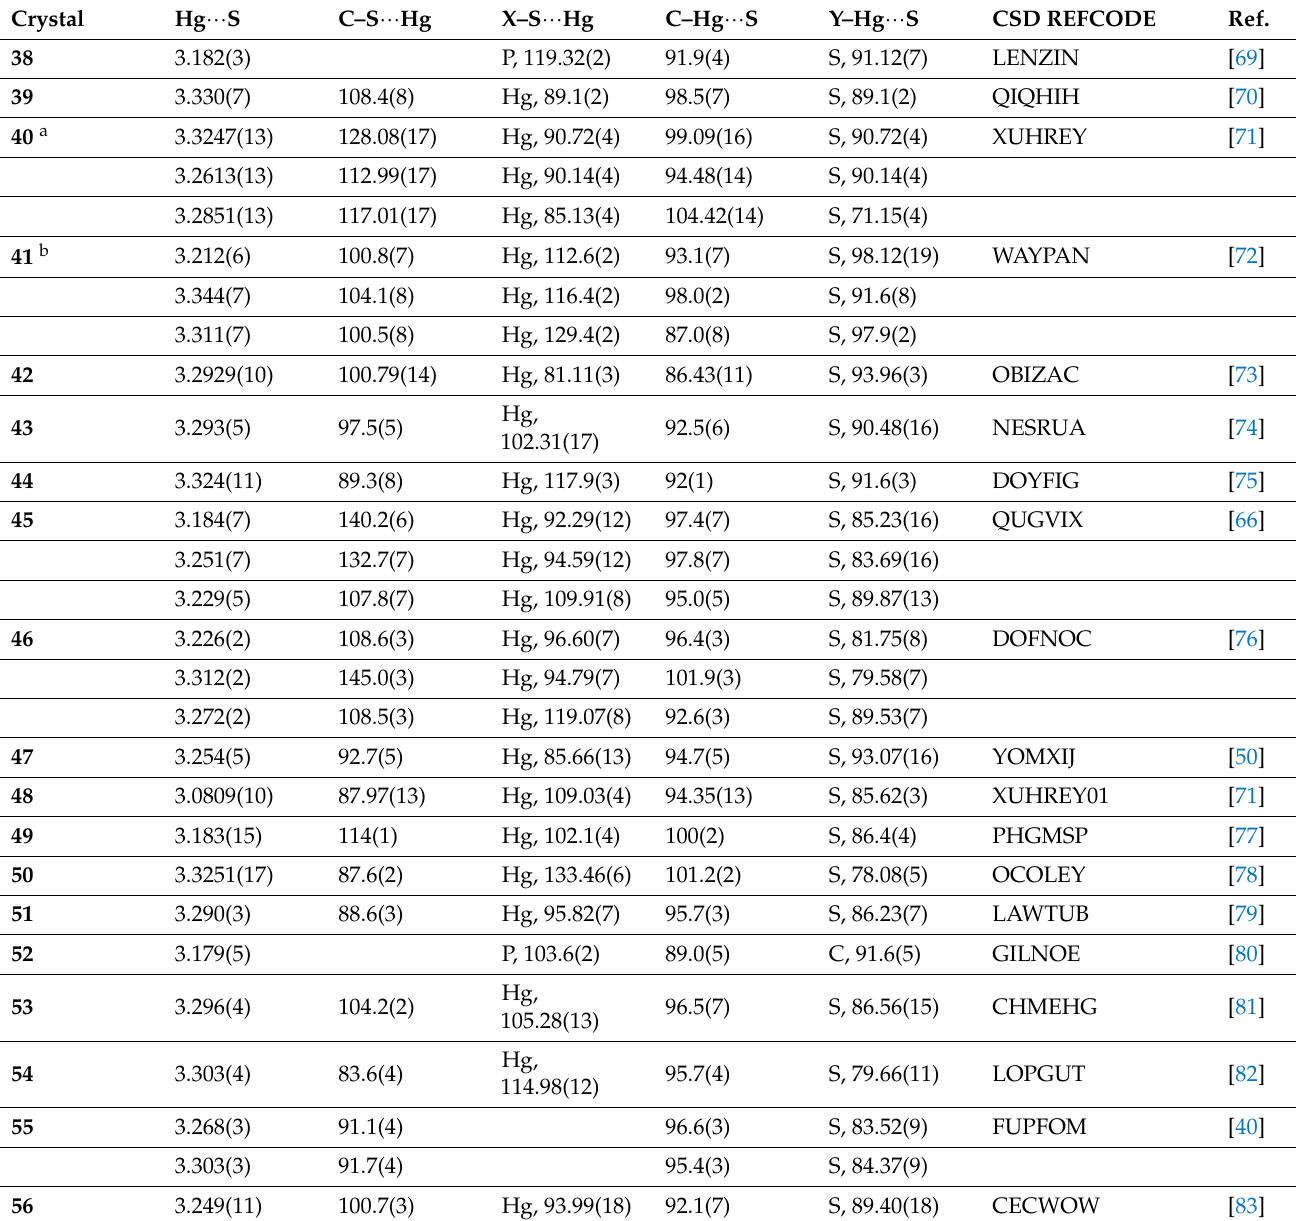
Table 4. Summary of geometric parameters (Å, ◦ ) for 30 – 37 , each featuring Hg ··· S contacts within one-dimensional